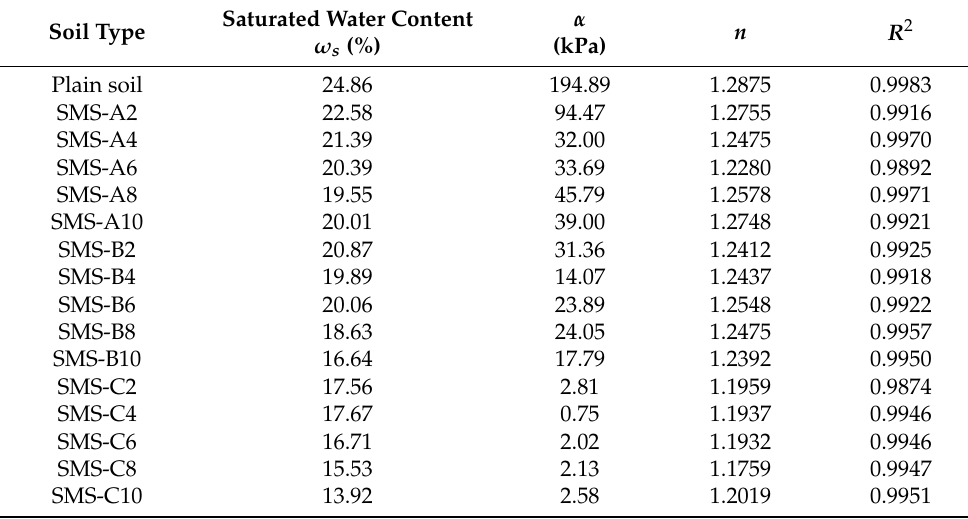
Table 3. Parameter summaries of VG model under different hydrophobic